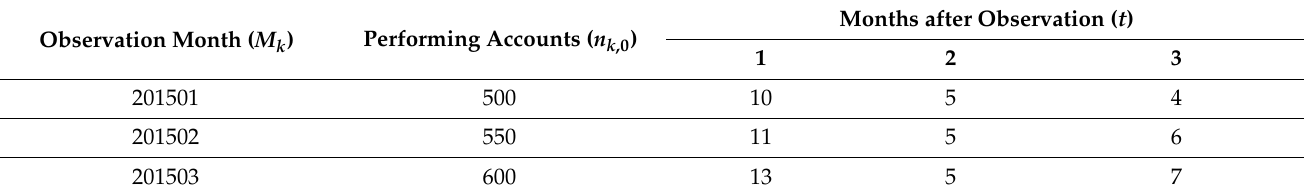
Table 3. Lorenz curve data extract from defaults table.